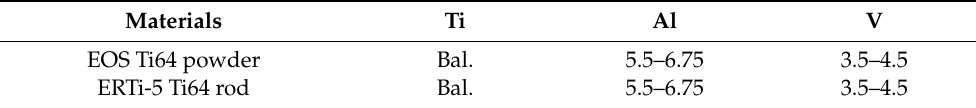
Table 1. Chemical composition of the used materials in wt%.